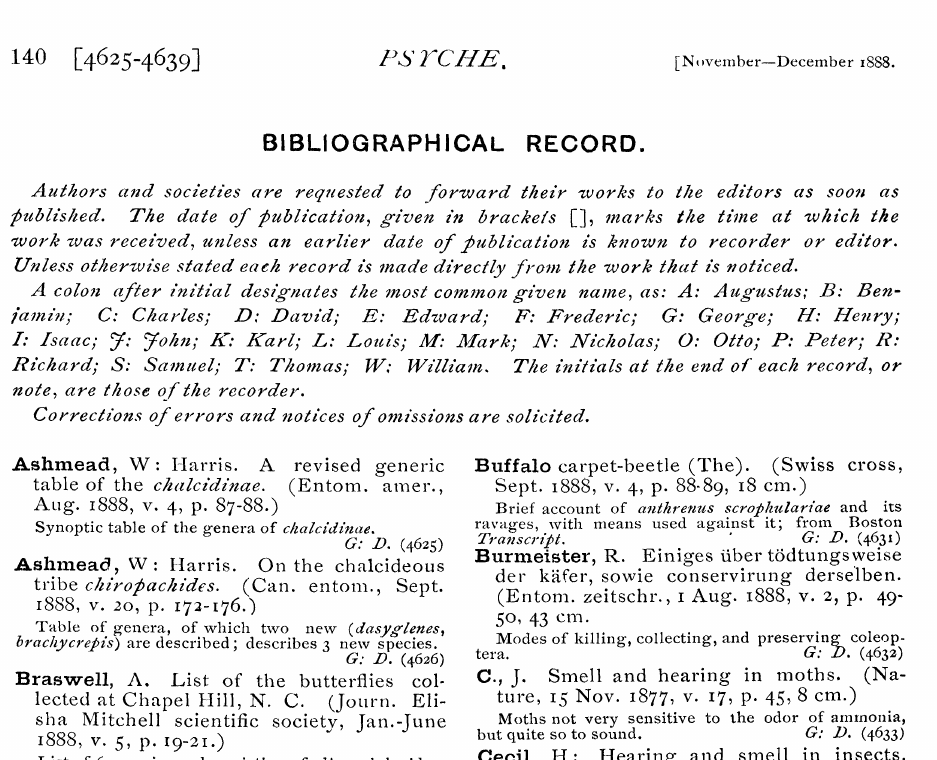
Table of genera, of which two (dasygrlenes,